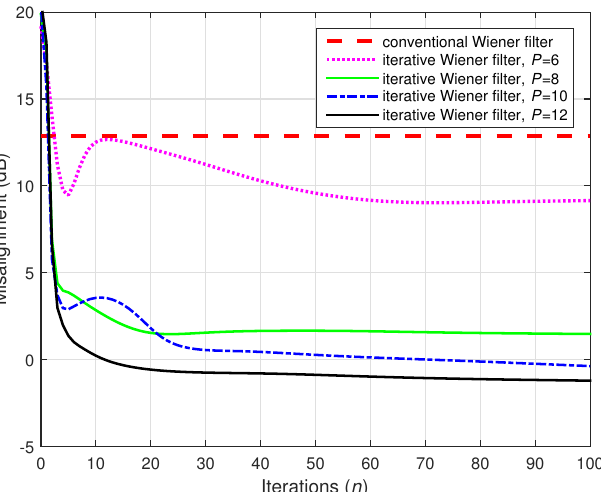
Figure 26. Performances of the conventional and iterative Wiener filters, using N = 10,000. The source signal (white Gaussian noise) was not preprocessed (no distortion, i.e., α = 0). The numbers of channels were M = 2 (stereophonic scenario), L = 1024, and SNR = 30